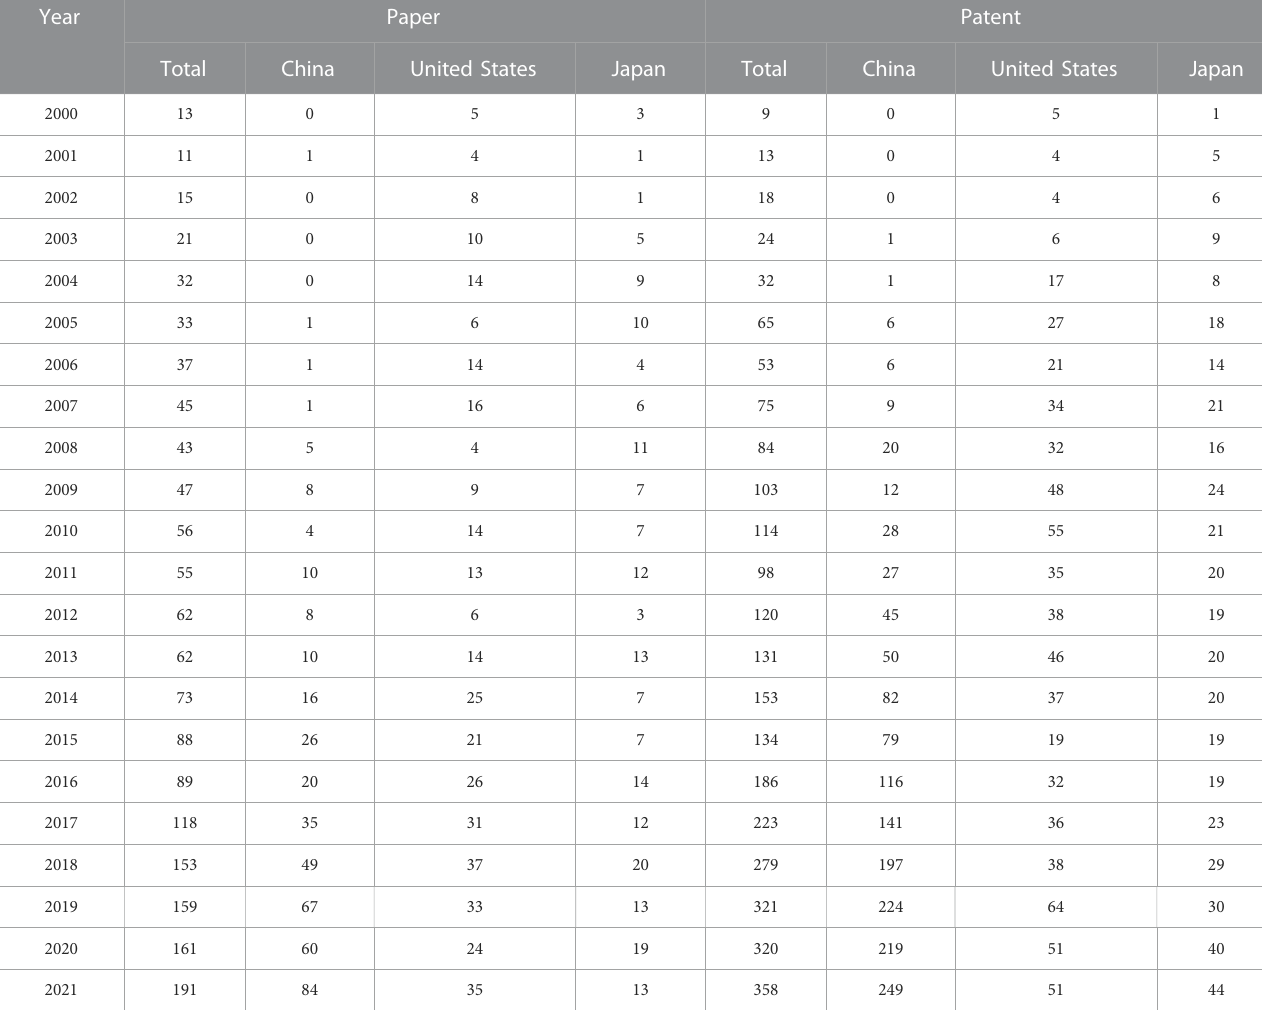
TABLE 1 Contribution of the top 3 most productive countries/regions in arti fi cial muscle